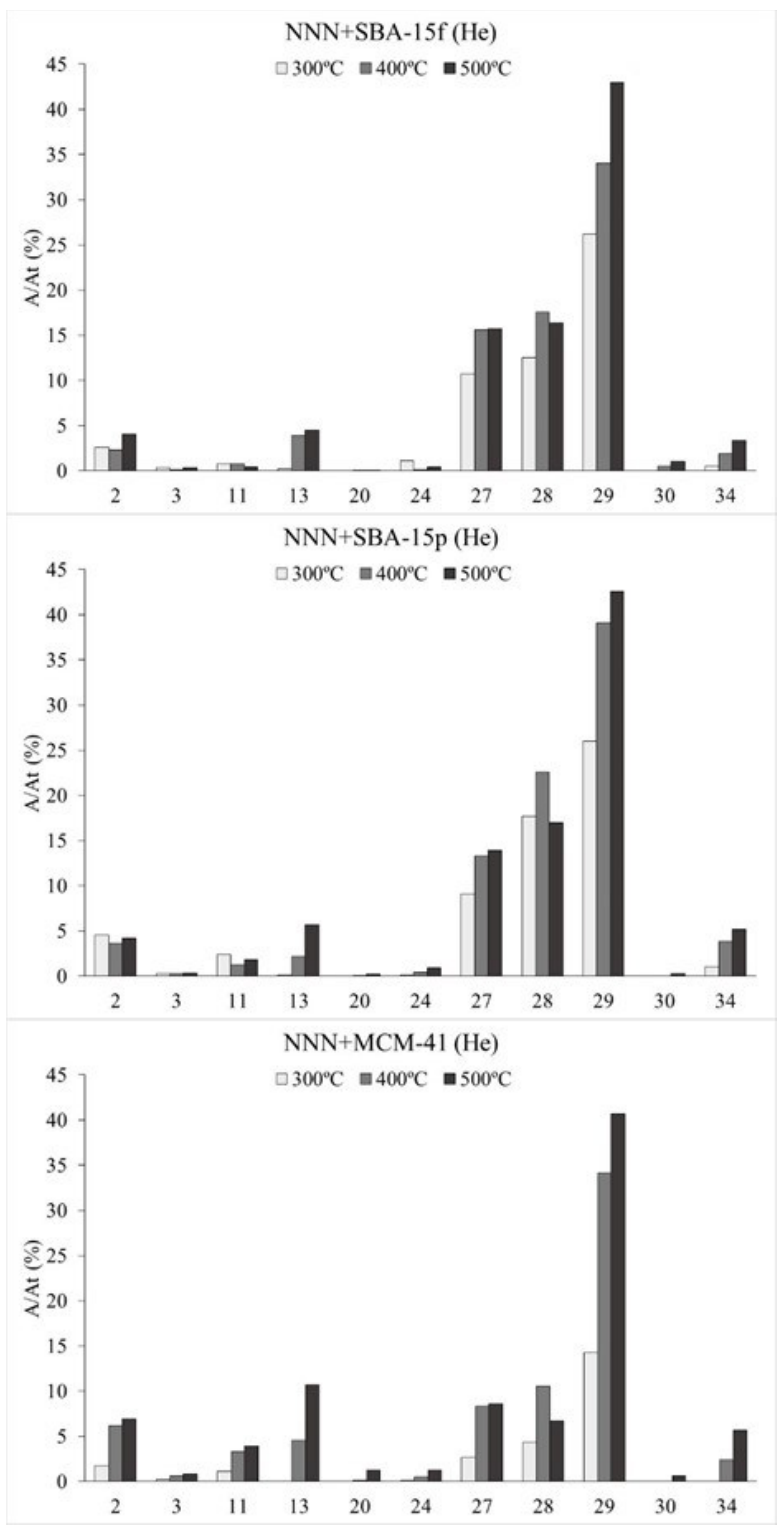
Figure 13. % area vs temperature of the majority compounds detected in the pyrolysis of NNN with three catalysts, under the inert atmosphere. Nitric oxide (2), 1-propene (3), 3-ethenyl-pyridine (11), 3-pyridinecarbonitrile (13), isoquinoline (20), nicotine (24), 1H-pyrrolo [2,3-b] pyridine (27), nornicotine (28), myosmine (29), 3,4-dimethyl-pyrrolo(1,2-a) pyrazine (30), nornicotiryne (34).